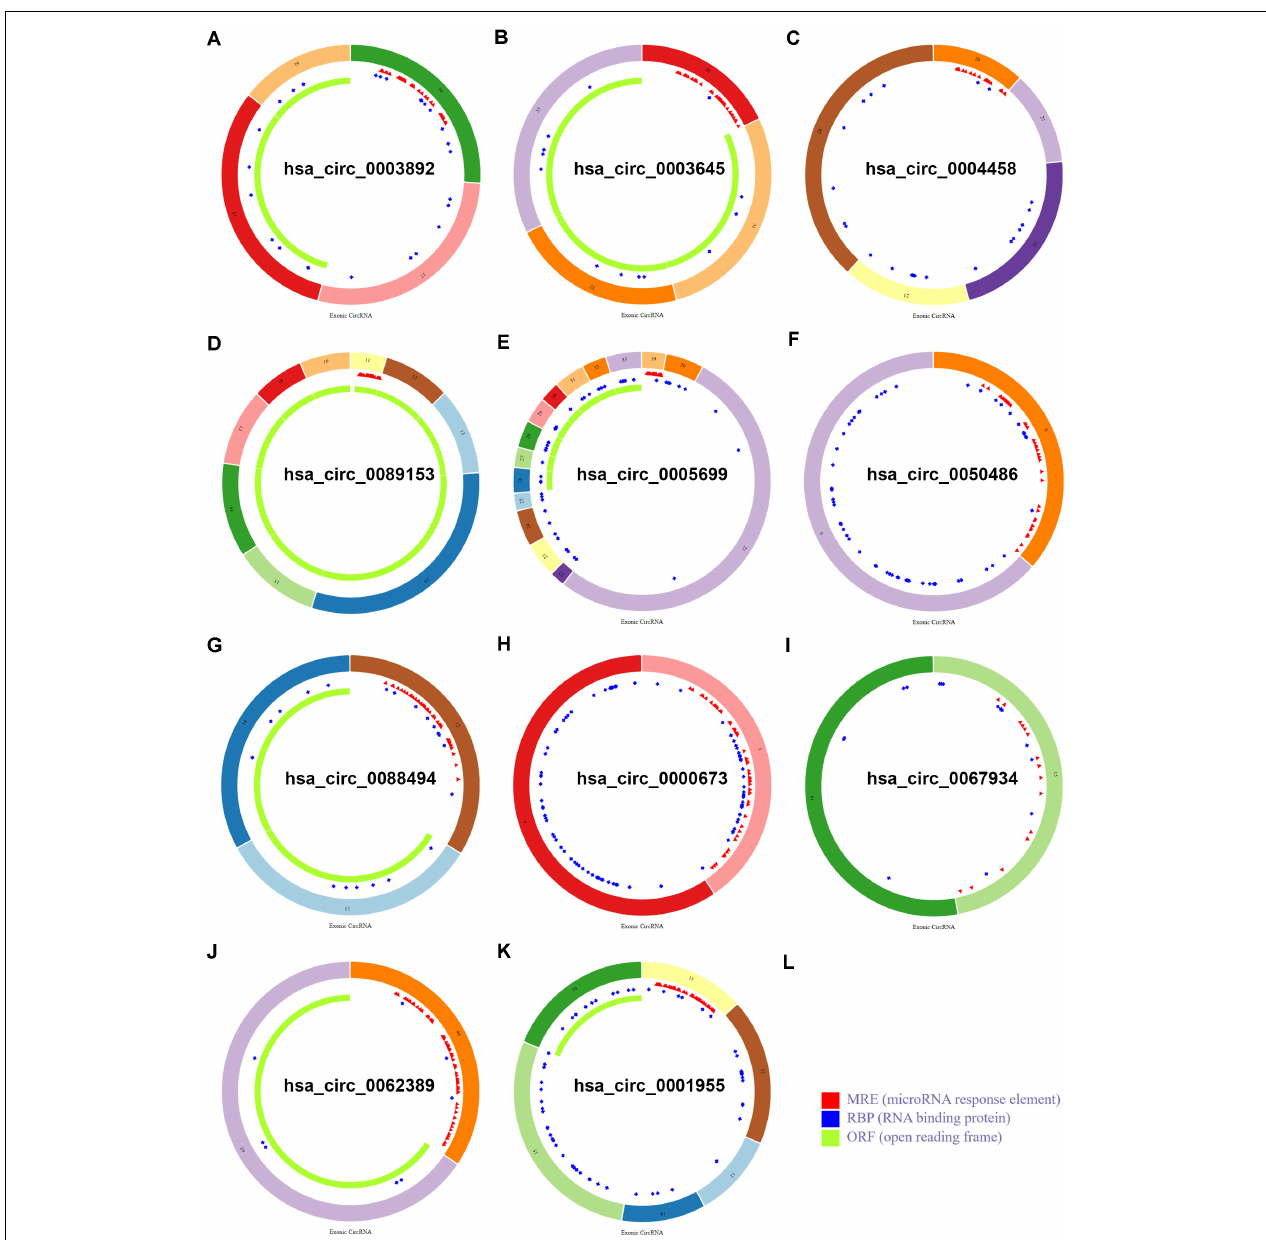
FIGURE 2 | Structural patterns of the 11 circRNAs in the CSCD database. (A) The structural pattern of hsa_circ_0003892. (B) The structural pattern of hsa_circ_0003645. (C) The structural pattern of hsa_circ_0004458. (D) The structural pattern of hsa_circ_0089153. (E) The structural pattern of hsa_circ_0005699. (F) The structural pattern of hsa_circ_0050486. (G) The structural pattern of hsa_circ_0088494. (H) The structural pattern of hsa_circ_0000673. (I) The structural pattern of hsa_circ_0067934. (J) The structural pattern of hsa_circ_0062389. (K) The structural pattern of hsa_circ_0001955. (L) The representation of MRE, RBP, and